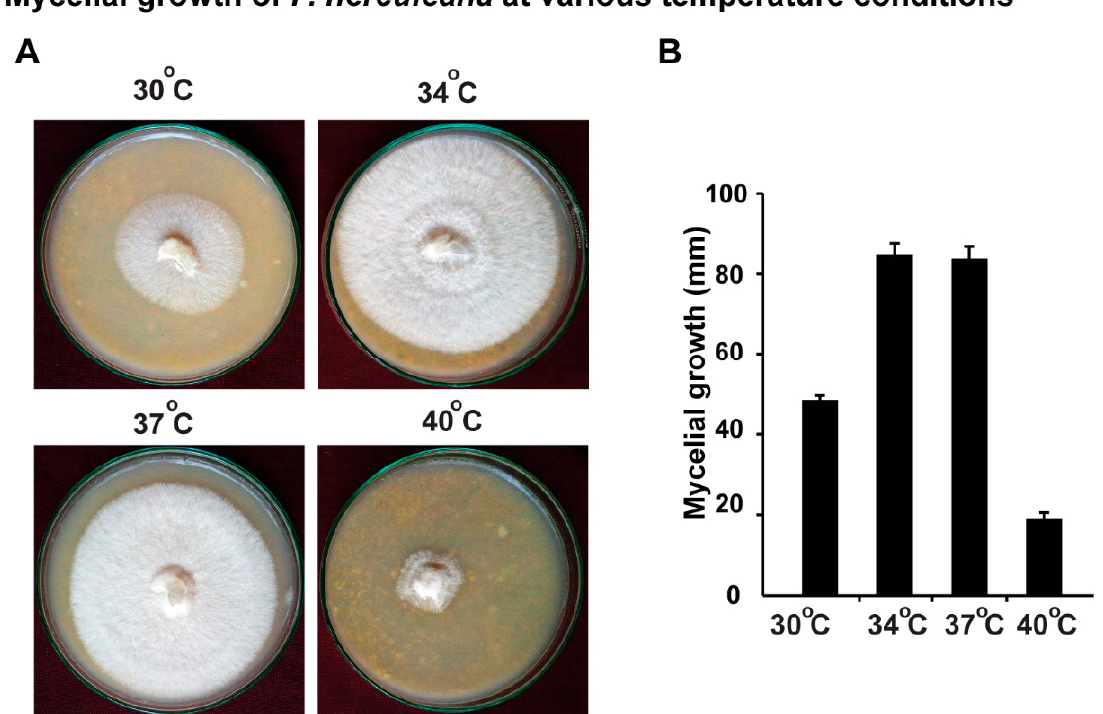
Figure 4. Mycelial growth of Phellorinia herculeana at various temperature conditions. ( A ): Mycelial growth of P. herculeana on maize agar medium incubated at different temperature conditions; ( B ): The radial growth of P. herculeana , grown at different temperature conditions, was measured in millimeter. Error bar indicates the standard deviations.